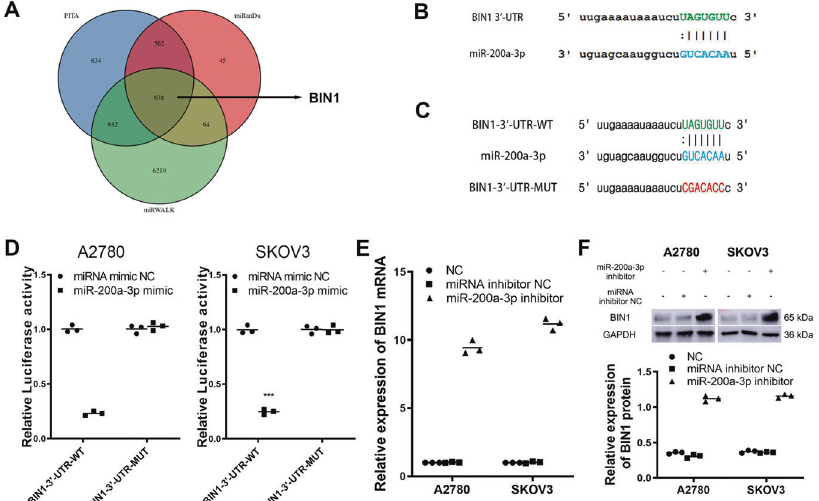
Fig. 5 BIN1 is a direct target of miR-200a-3p in EOC cells. A BIN1 was contained in the overlapped result from the bioinformatic algorithm PITA, miRanDa and miRWALK. B The predicted binding between miR-200a-3p and BIN1-3 ’ -UTR. C The sequences of BIN1-3 ’ -UTR-WT and BIN1- 3 ’ -UTR-MUT. D miR-200-3p mimic decreased the luciferase activity of EOC cells transfected with BIN1-3 ’ -UTR-WT but not in the cells transfected with BIN1-3 ’ -UTR-MUT. E The miR-200a-3p inhibitor increased the expression of BIN1 mRNA in EOC cells. F The miR-200a-3p inhibitor increased the expression of BIN1 mRNA in EOC cells. The experiments were conducted in